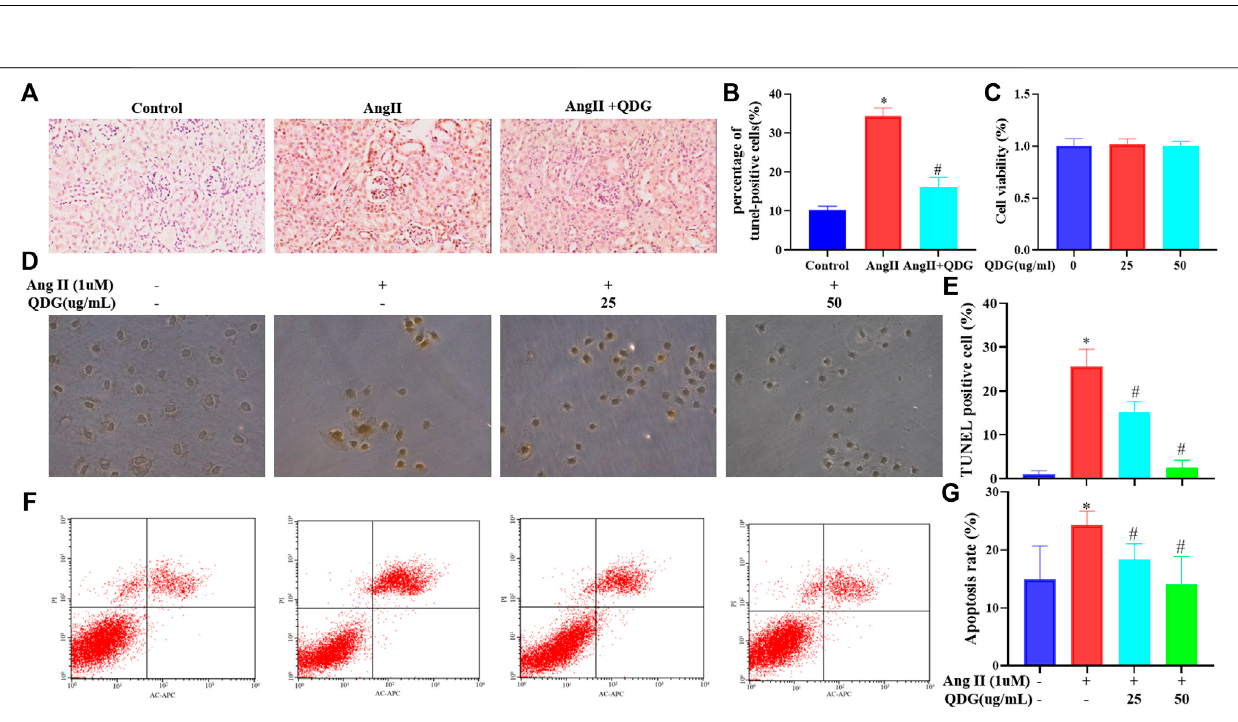
Frontiers in Pharmacology |